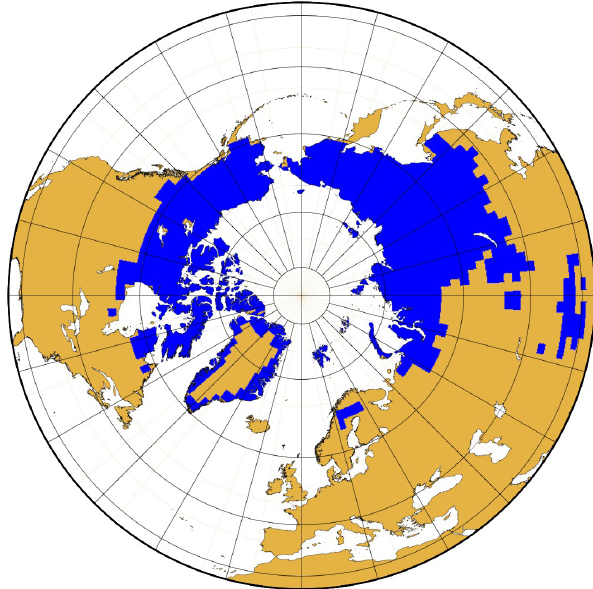
Figure 4. Region of study (blue), which corresponds to the extent of near-surface permafrost in the Northern Hemisphere in the year 1901, for the original CLM4.5